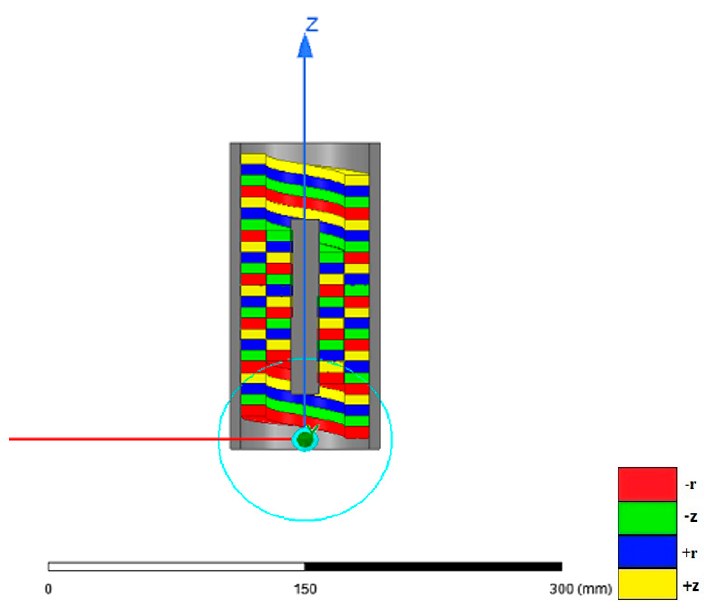
Figure 11. 3D FEA model (Cross-Sectional View).